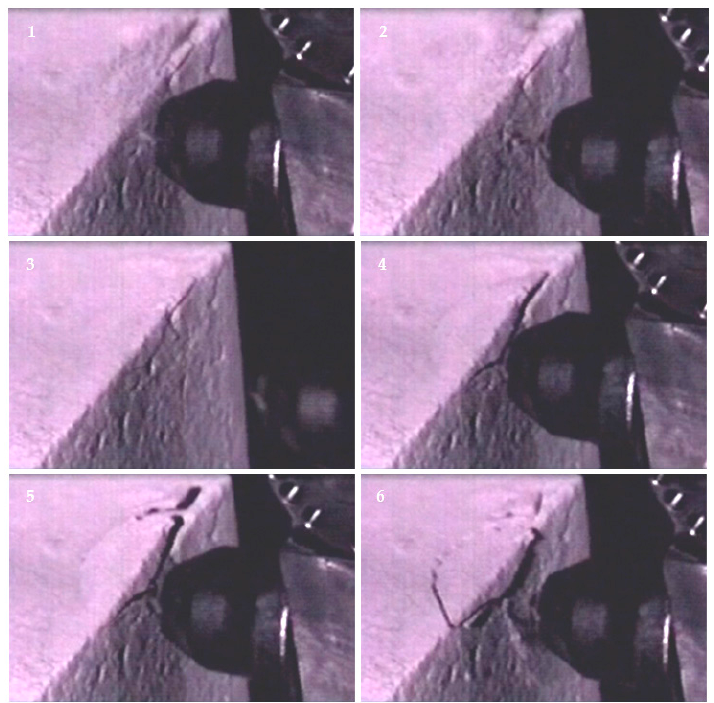
Figure 13. Test 2. Impact energy of 34.1 J. 1 . First impact of the pick on the test sample. 2 . Distance of the pick from the test sample. 3 . Approximation of the pick to the test sample in the rebound. 4 . Second impact of the pick on the test sample. 5 . Deformation of the test sample and creation of the chip. 6 . Distance of the pick from the test sample after the second impact.